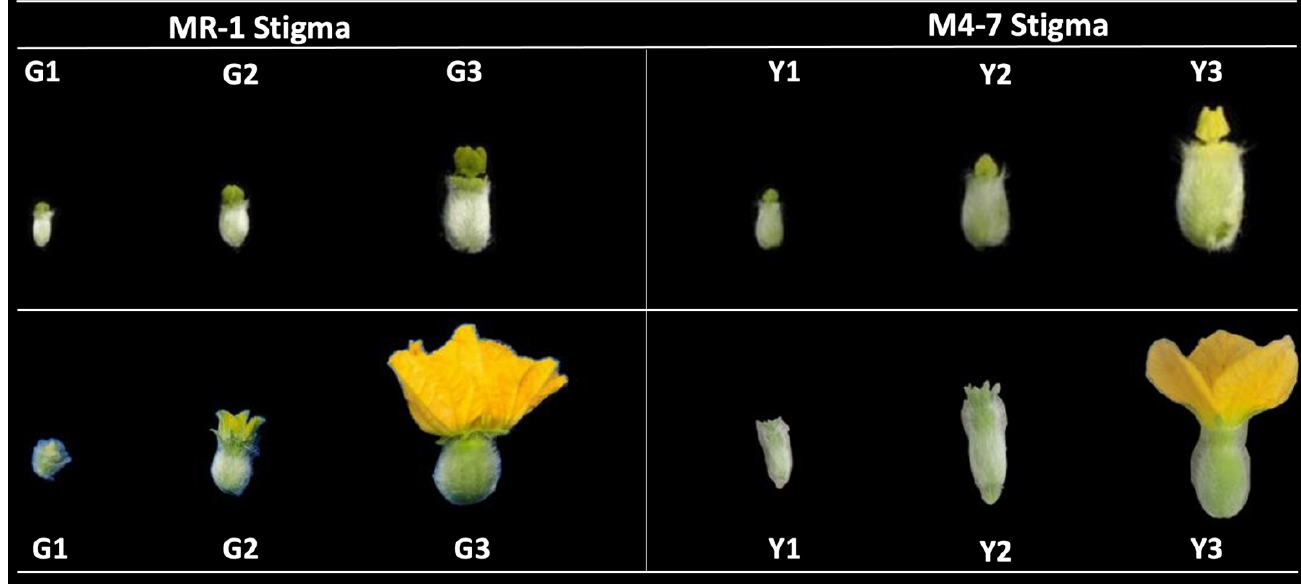
Figure 1. A pictorial view of contrasted melon stigmas (green: “G”; yellow: “Y”) at three key developmental stages.